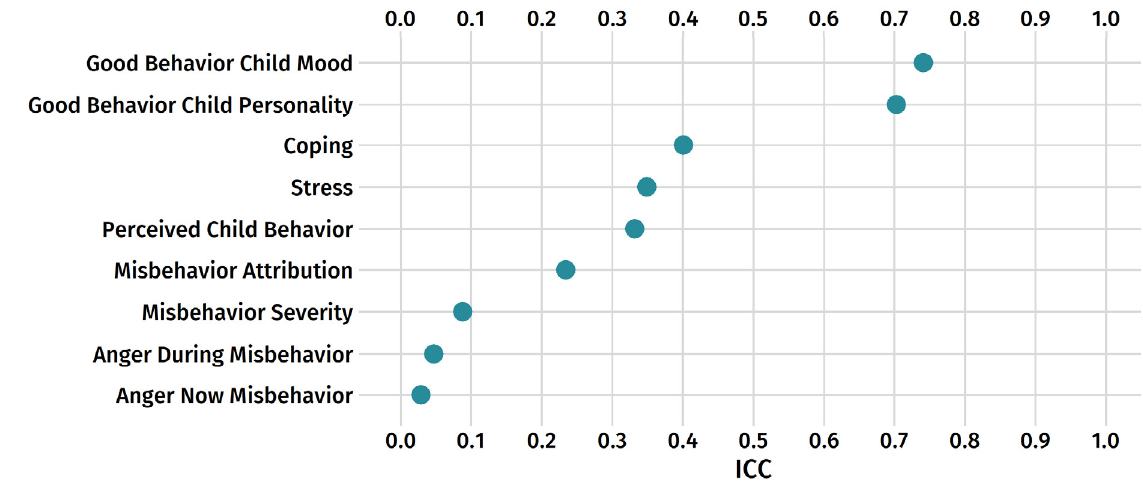
Figure 2. Intraclass correlations for daily reports (items sorted by largest to smallest).